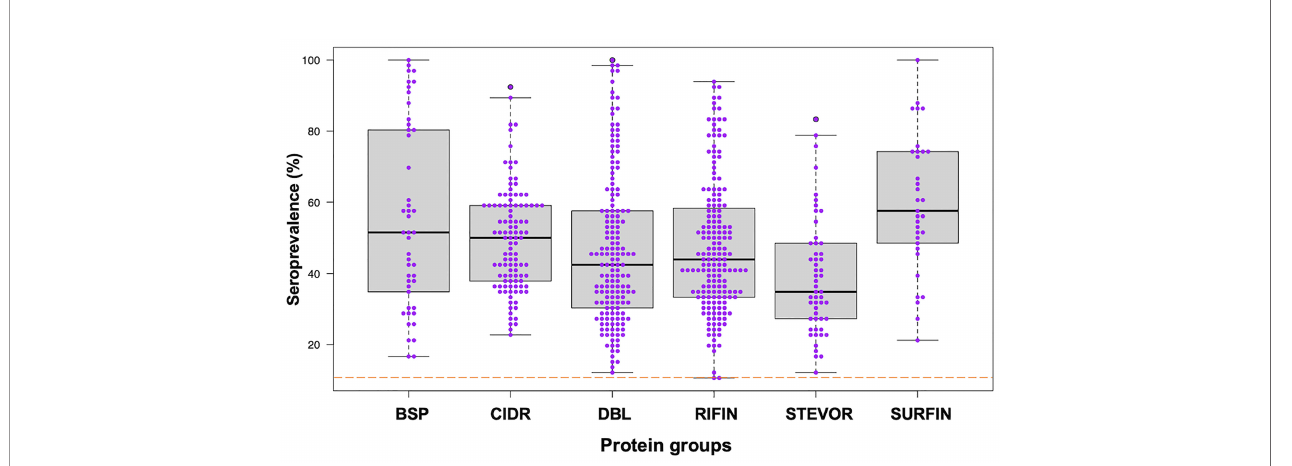
FIGURE 1 | Seroprevalence of antibodies to different P. falciparum proteins. Antibodies immunoreactive to BSP (blood-stage proteins), CIDR (cysteine-rich interdomain regions of PfEMP1), DBL (Duffy binding – like domains of PfEMP1), RIFIN (repetitive interspersed family proteins), STEVOR (subtelomeric variable open reading frame proteins), and SURFIN (surface-associated interspersed gene family proteins) are shown. Box plots illustrate medians with 25 th and 75 th and whiskers for 10 th and 90 th percentiles with the horizontal line in each group denoting the overall median per group. The dashed red horizontal line indicates 10% seroprevalence that was set as protein immunoreactivity cut-off point. The data in BSP were newly measured in this study. The data in other protein groups, CIDR and DBL from PfEMP1, RIFIN, STEVOR and SURFIN were reported previously (11,